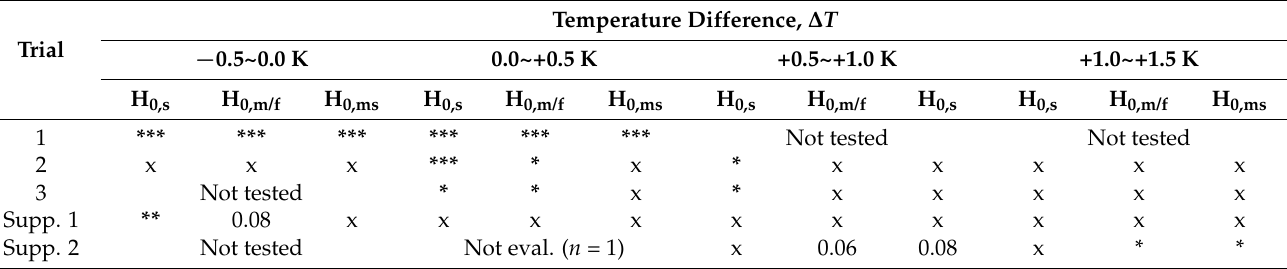
Table 5. Summary of experiment trial statistical